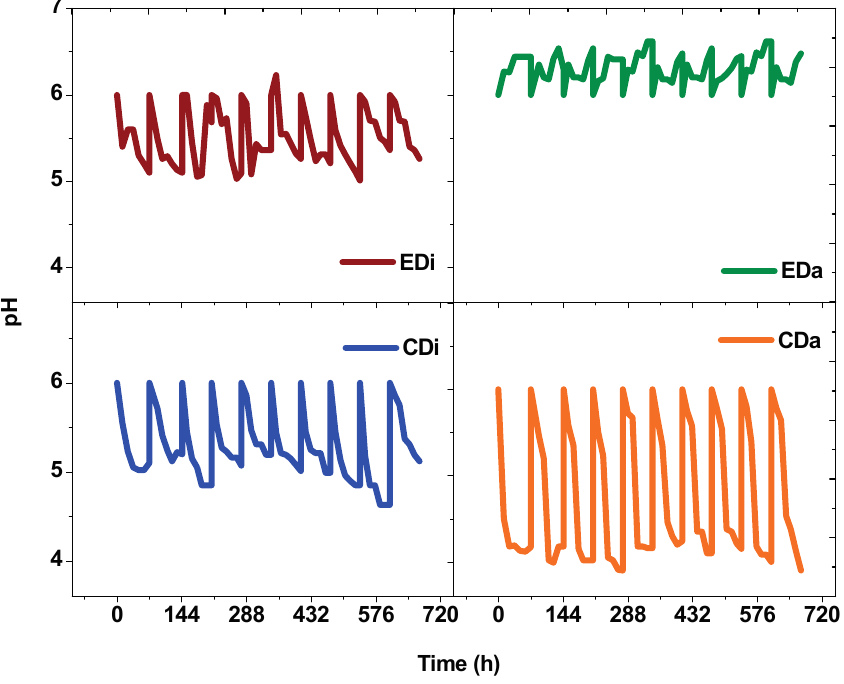
Figure 4. Changes in pH profile as function of time with dairy and distillery wastewater in dark-fermentative system (DFS-CDi, CDa) and augmented dark-photo fermentative system (ADPFS-EDi,